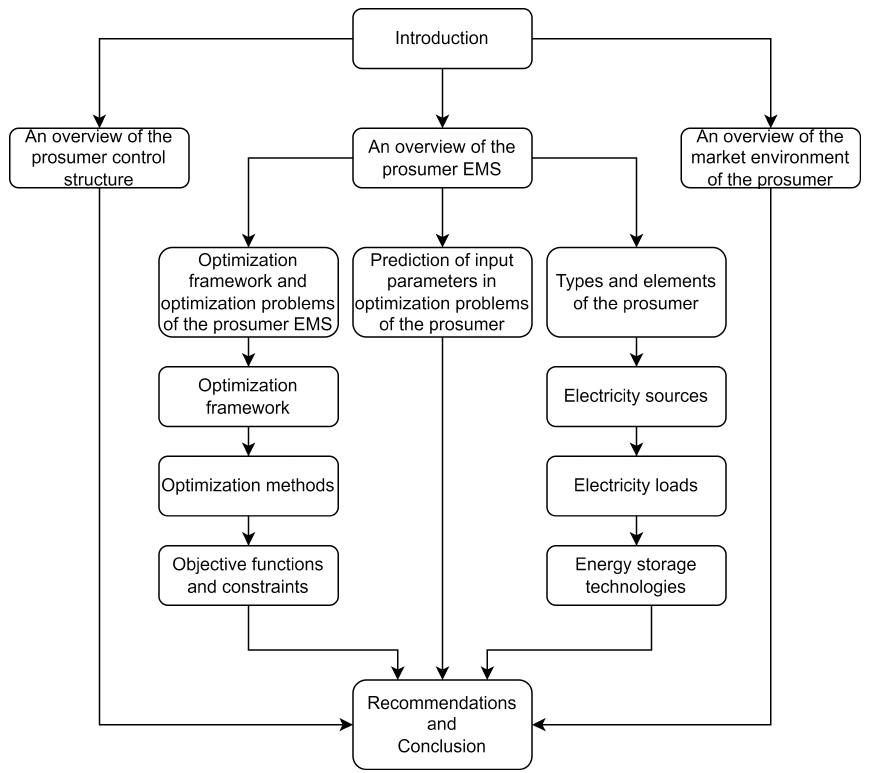
Figure 2. A review structure of the paper includes all section and